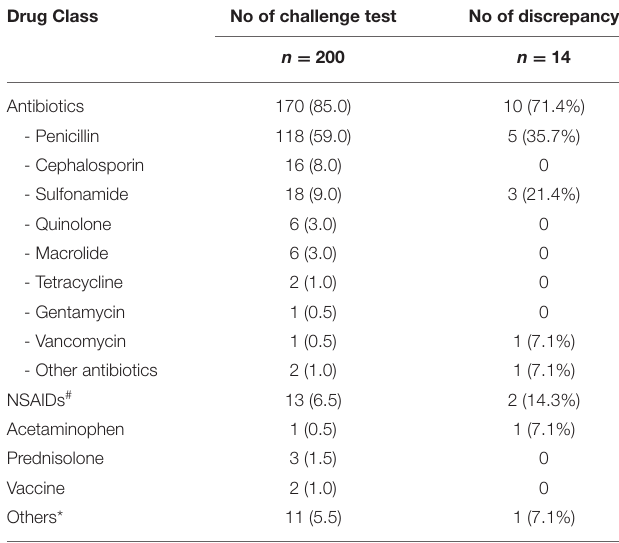
Frontiers in Allergy |